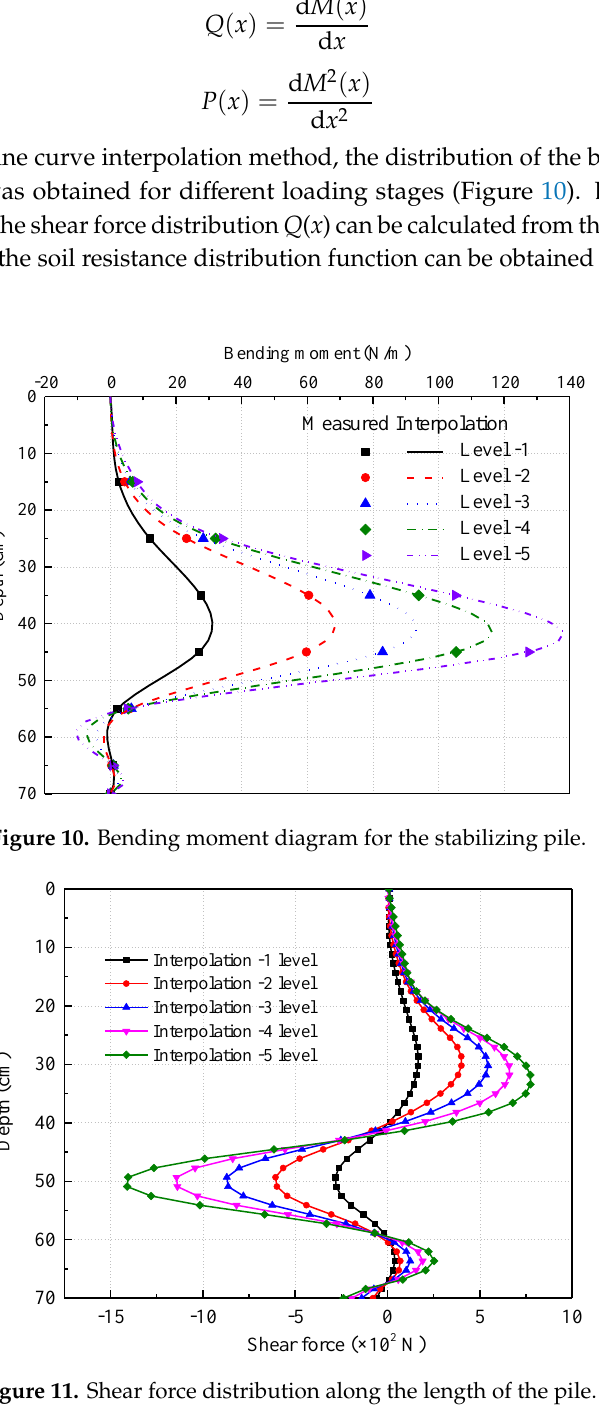
Figure 12. Soil resistance distribution along the length of the pile. The distribution of the moment is obtained by using MATLAB (cubic spline interpolation). Through the first and second derivation of the bending moment, the distribution of the pile shear force and the distribution of the geotechnical resistance were obtained, respectively, and the displacement distribution of the pile body was obtained from the second integral of the bending moment. The displacement of the top pile is in accordance with the measured values (Figure 13), while the increase of the load classification, the point of the shear force that is zero, gradually moves down (Figure 11). It is also illustrated that the point of the maximum moment value gradually moves downward. The results illustrate that the loading ways and time should be considered in the design of stabilizing piles.